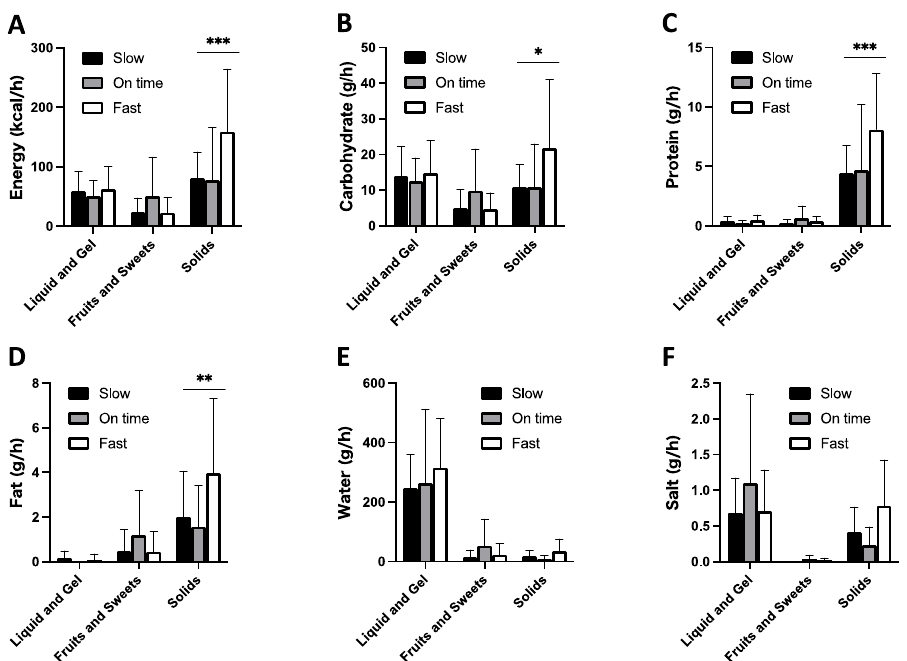
Figure 6. Comparison of product type for energy ( A ), carbohydrate ( B ), protein ( C ), fat ( D ), water ( E ), and salt ( F ) consumption among different running paces (fast, when the running pace was faster than planned; on time, when the running pace was the same as planned; slow, when the running pace was slower than planned). * p < 0.05, ** p < 0.01, *** p < 0.001 between fast and slow, Mann–Whitney test. Values are means ± SEM.